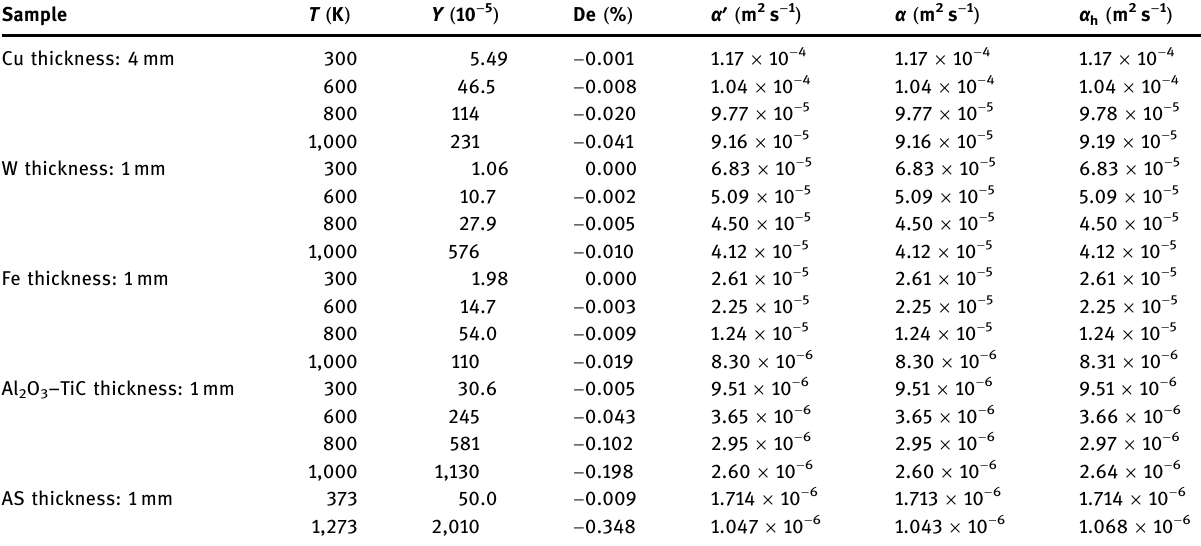
Table 1: Calculated Biot number Y , deviation of slope De ( % ) , input thermal di ff usivity values α ′ ( m 2 s − 1 ) , estimated thermal di ff usivity values α ( m 2 s − 1 ) , and thermal di ff usivity values evaluated by halftime method α h ( m 2 s − 1 ) of copper ( Cu ) , tungsten ( W ) , iron ( Fe ) , alumina – titanium carbide ceramics ( Al 2 O 3 – TiC ) , and aluminum silicate ( AS ) samples at various temperatures T ( K )